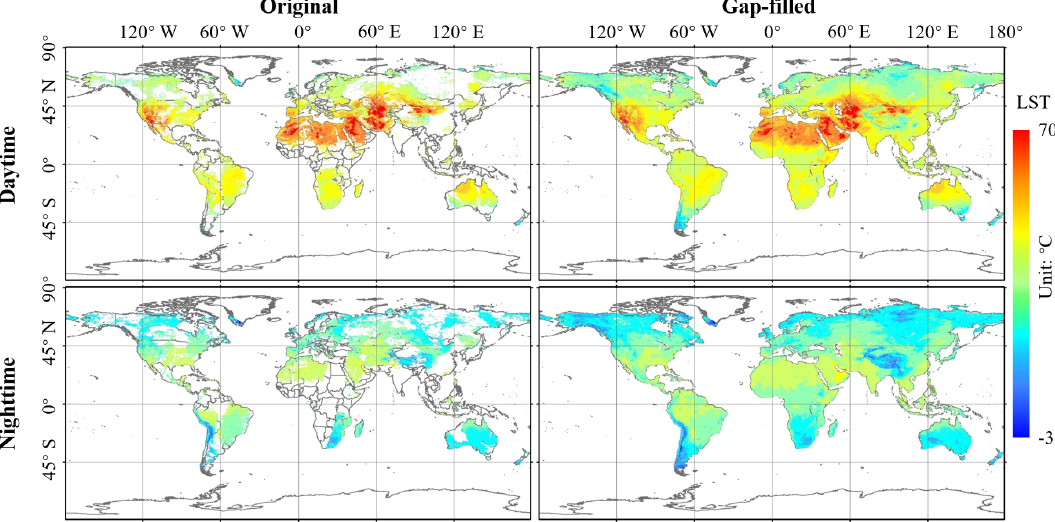
Figure 6. Spatial pattern of the original and gap-filled LSTs at global scale on day 200 of year 2020.